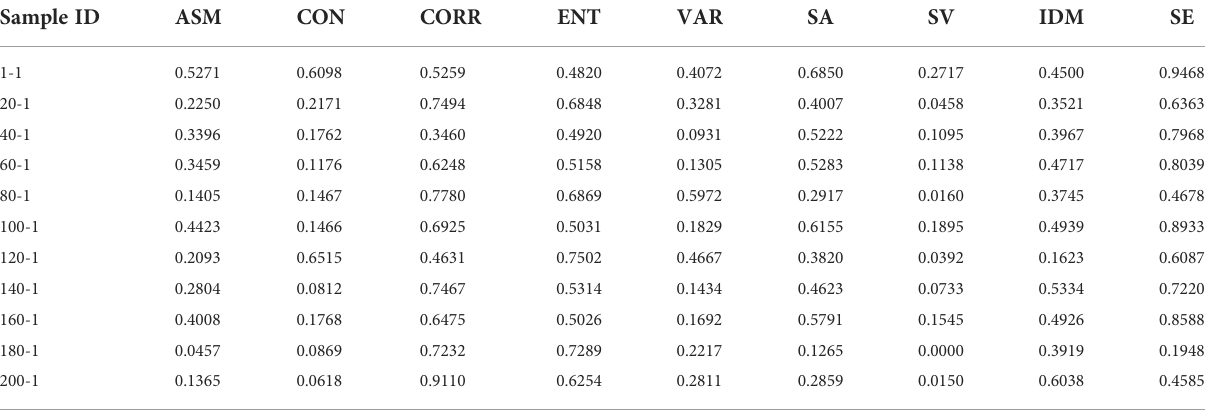
TABLE 3 Eigenvalues of the grey co-occurrence